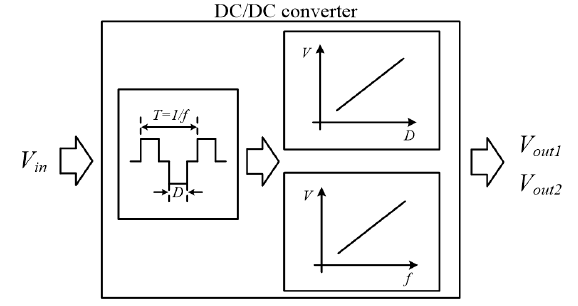
Figure 1. Concept of dual-output control.